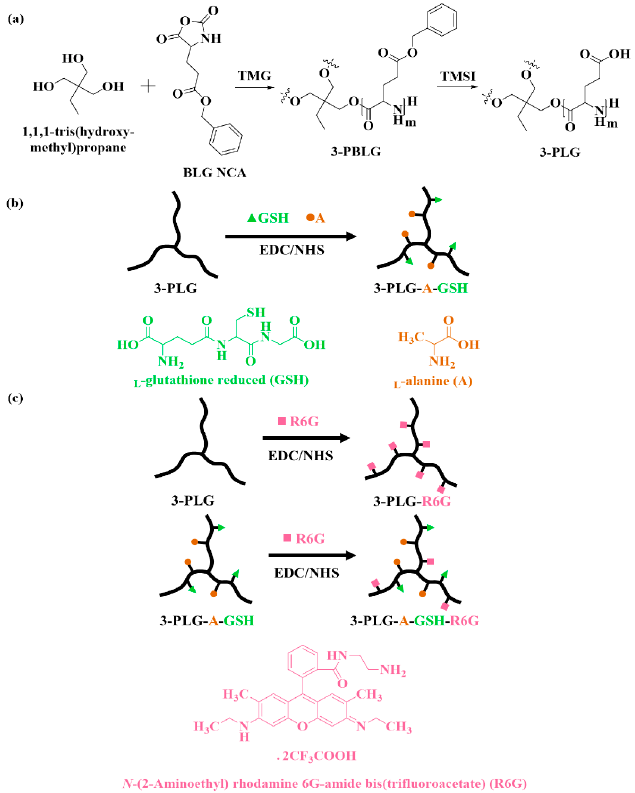
Figure 1. ( a ) Synthesis of 3-armed poly( L -glutamic acid γ -benzyl ester) (3-PBLG) and deprotection of benzyl groups to prepare 3-armed poly( L -glutamic acid) (3-PLG), ( b ) Synthesis of L -alanine (A) and glutathione (GSH)-targeted, 3-armed poly( L -glutamic acid) (3-PLG-A–GSH), ( c ) Synthesis of rhodamine 6G (R6G), labeled 3-PLG-R6G or